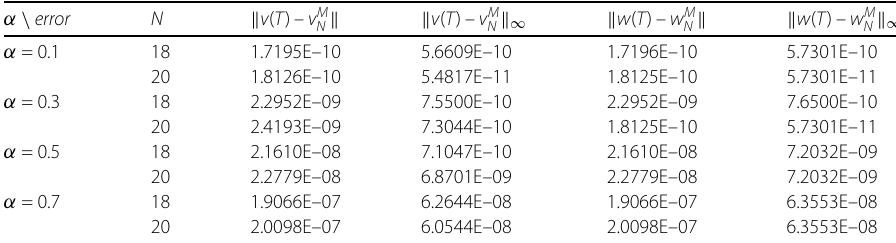
Table 3 L 2 , L ∞ errors of v and w at (cid:2) t = 10 –4 for Example 4.1 α \